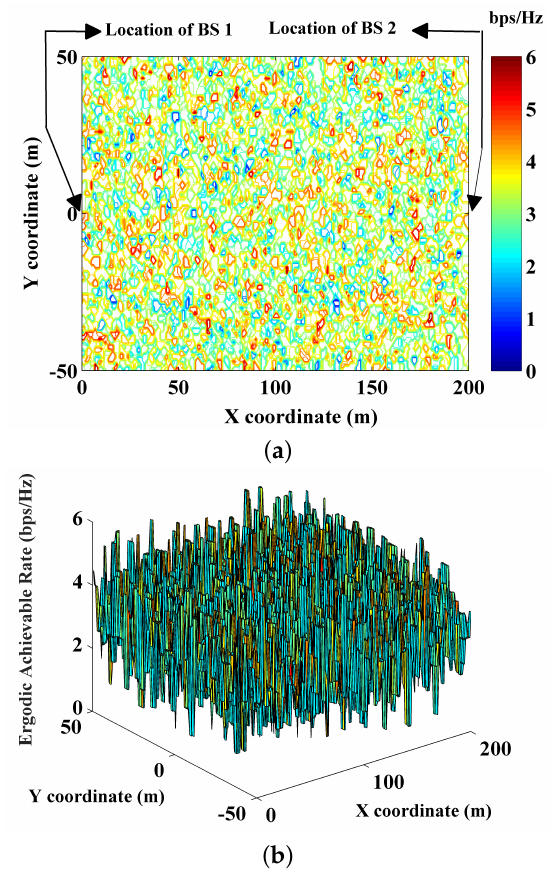
Figure 15. Estimated ergodic achievable rate under the studied area of 200 m × 100 m serving two BSs of identical height at 100 m and transmission power of 5 kW represented by ( a ) a two − dimensional surface plot and ( b ) a three − dimensional contour